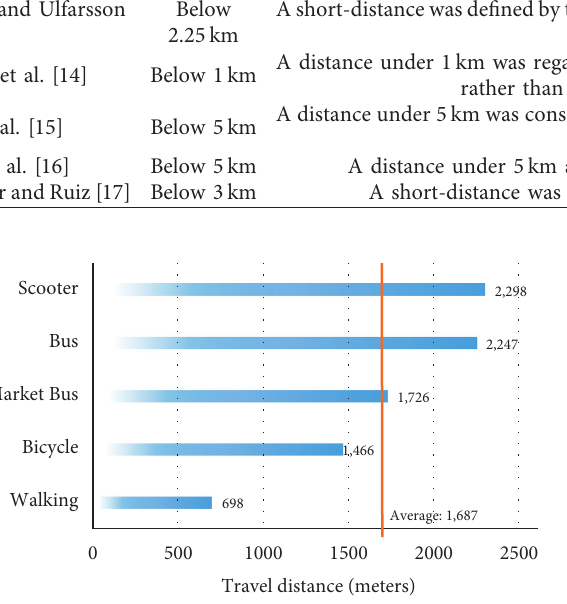
Figure 1: Average travel distances of each mode taken for the short-distance trip